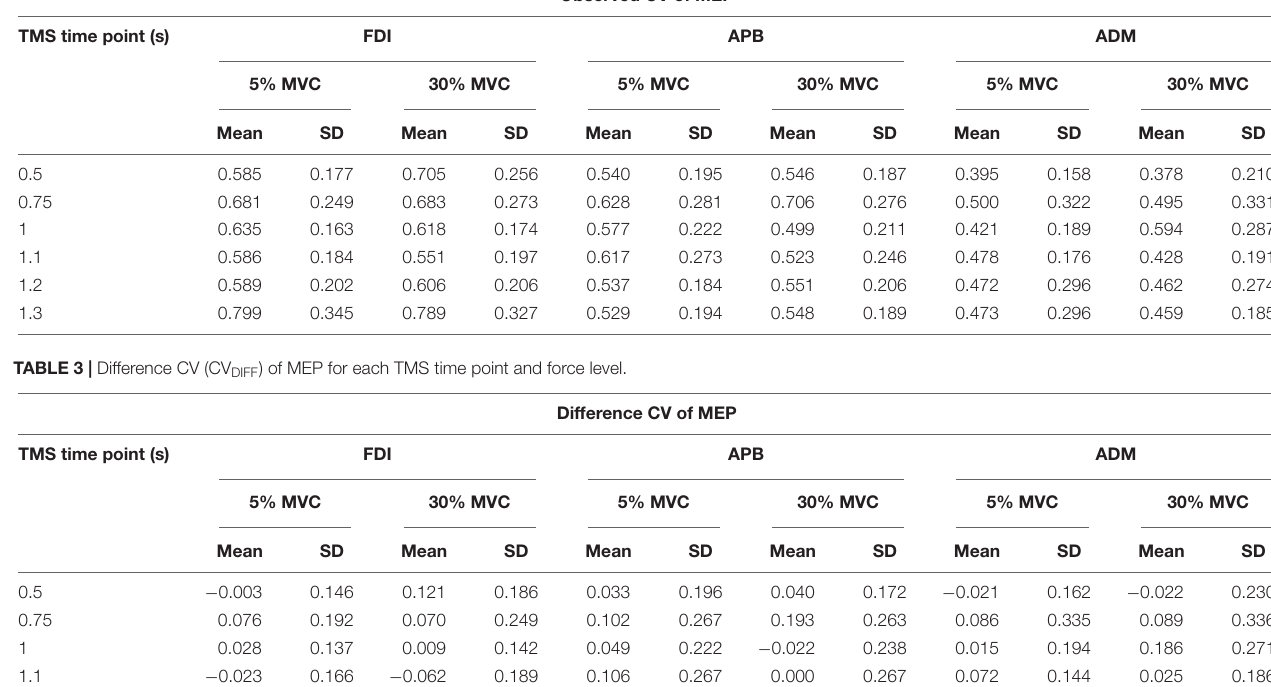
Observed CV of MEP